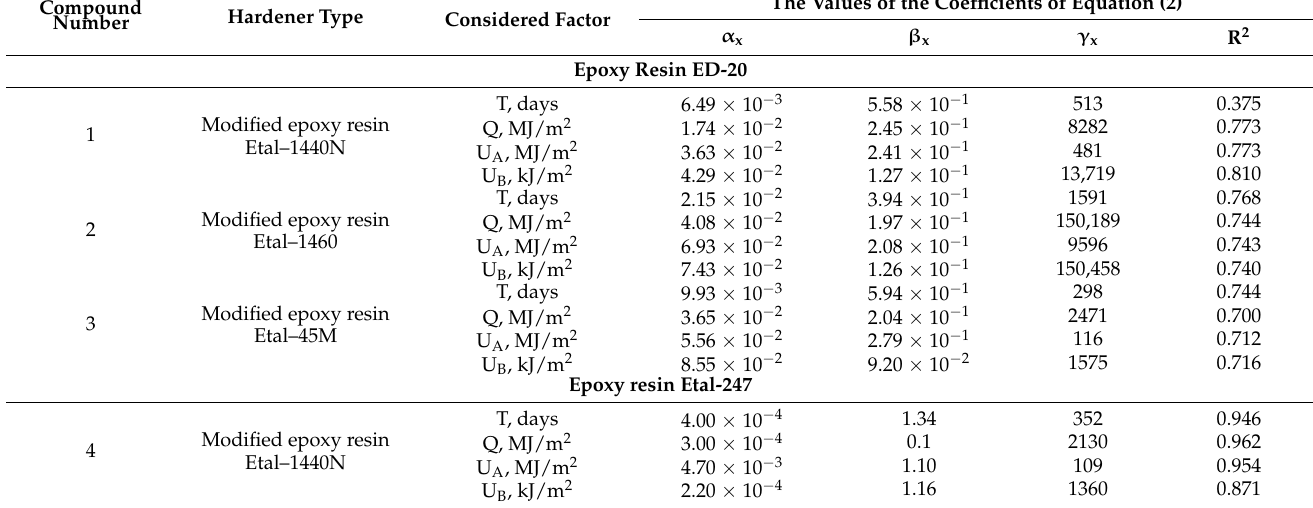
Table 5. Values of the coefficients of Equation (2), which describes the effect of the exposure time ( T ), the intensity of total solar radiation ( Q ) and ultraviolet radiation of the A ( U A ) and B ( U B ) ranges on the total color difference of the epoxy polymers exposed to natural climatic conditions (direct scan